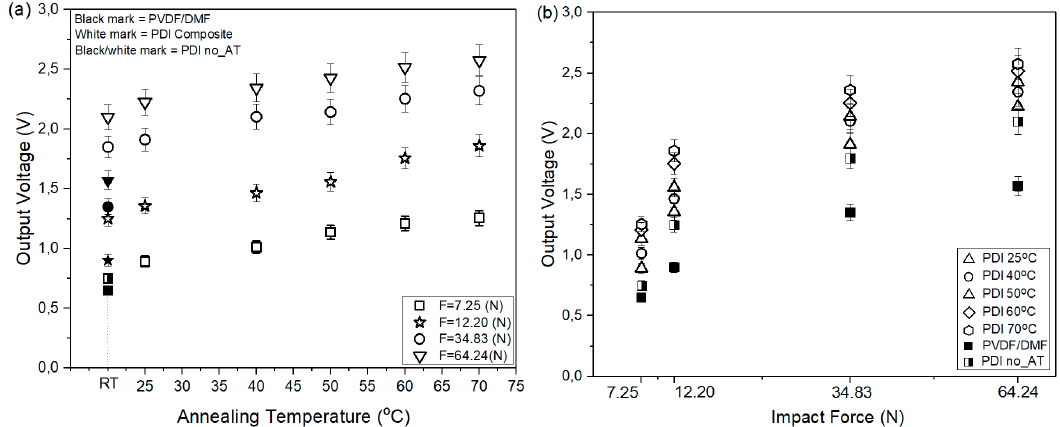
Figure 6. Output voltage response ( d 33 ) vs. impact force and annealing temperature. ( a ) The output voltage response for each fabricated PVDF film at di ff erent annealing water temperatures with expression of error bars; ( b ) the average output voltage response versus impact force.